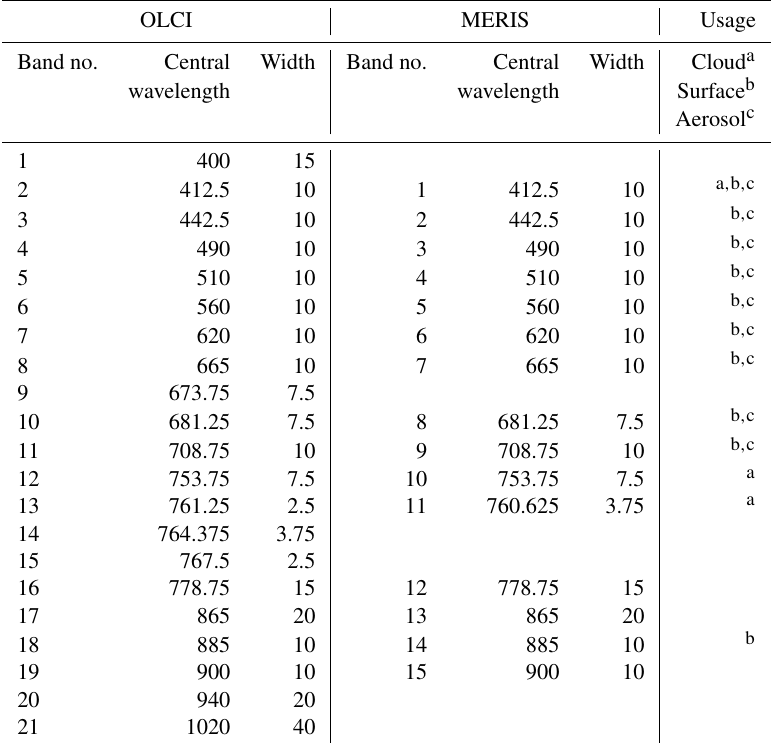
Table 1. Spectral channels for MERIS and OLCI instruments. OLCI MERIS Usage Band no. Central Width Band